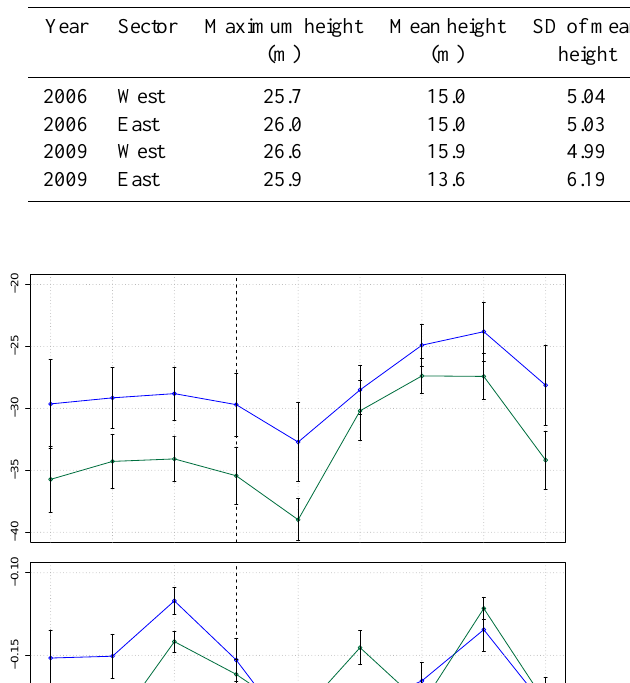
Table 4. Results of aerial lidar surveys before and after thinning calculated from first- and last-return data at a point density of 2pointsm − 2 and extracted from a 1ha gridded canopy height model at the Straits Inclosure, Alice Holt Forest. C.V.: coefficient of variation.